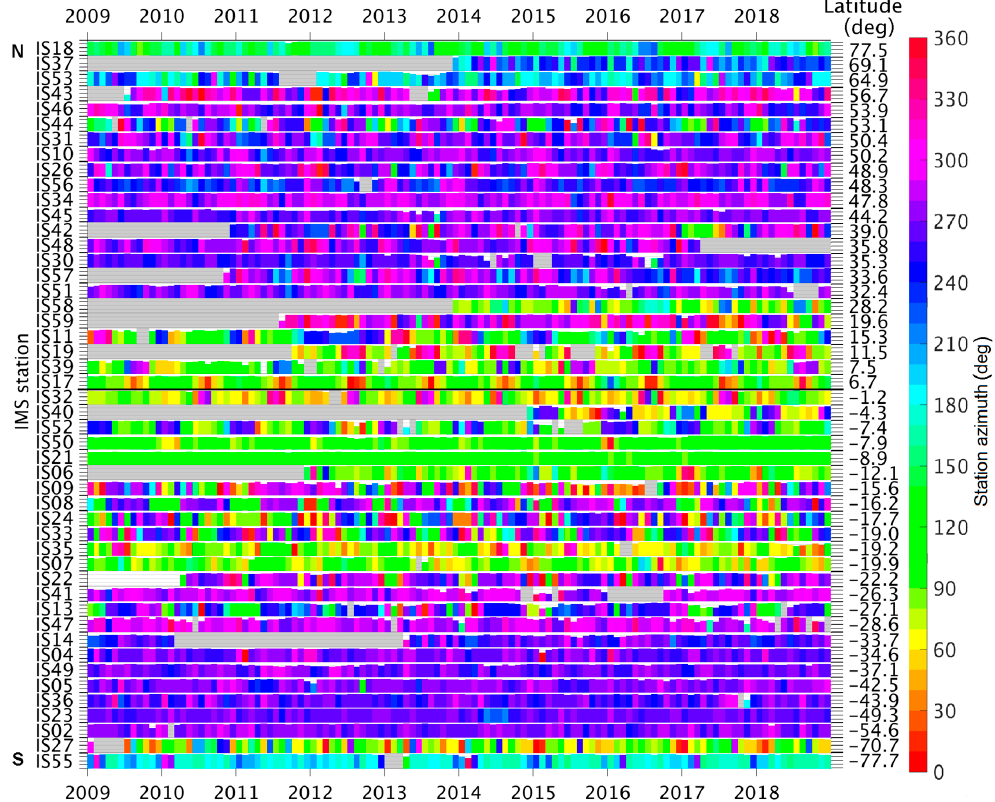
Figure A1. As Figure 3, but for the short-period configuration (1–20 min).